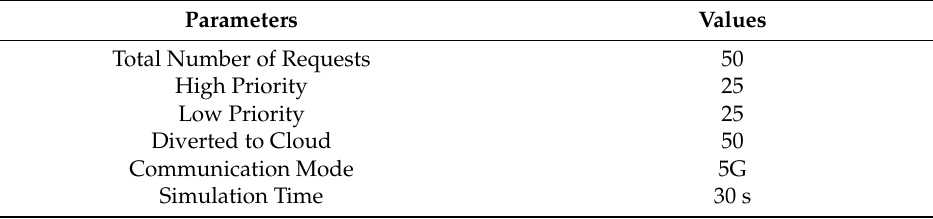
Table 4. Cloud scenario 1.